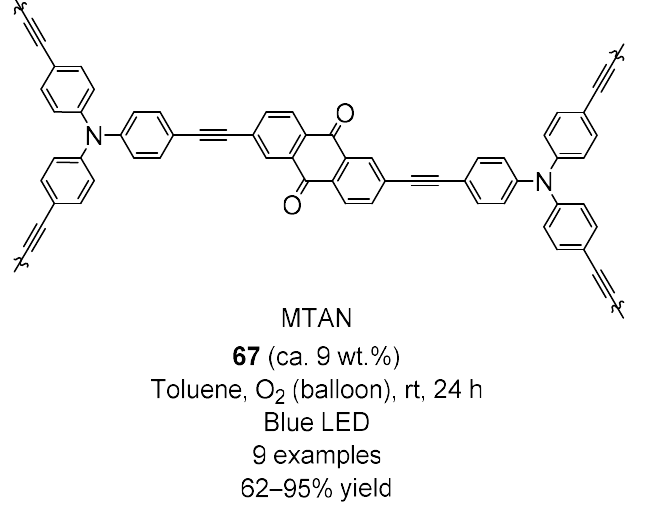
Figure 18. Results obtained in the aerobic photo-oxidative coupling of benzylamines to N -benzylidene benzylamines 2 catalyzed by 67 .